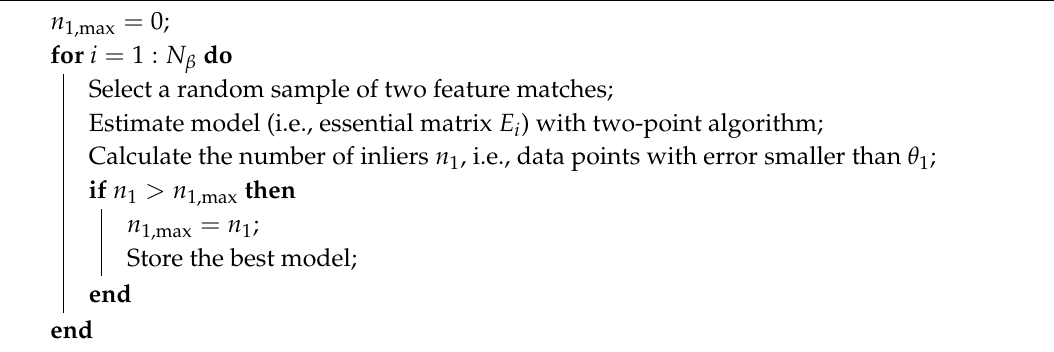
Algorithm 1: Essential matrix RANSAC estimation with the two-point